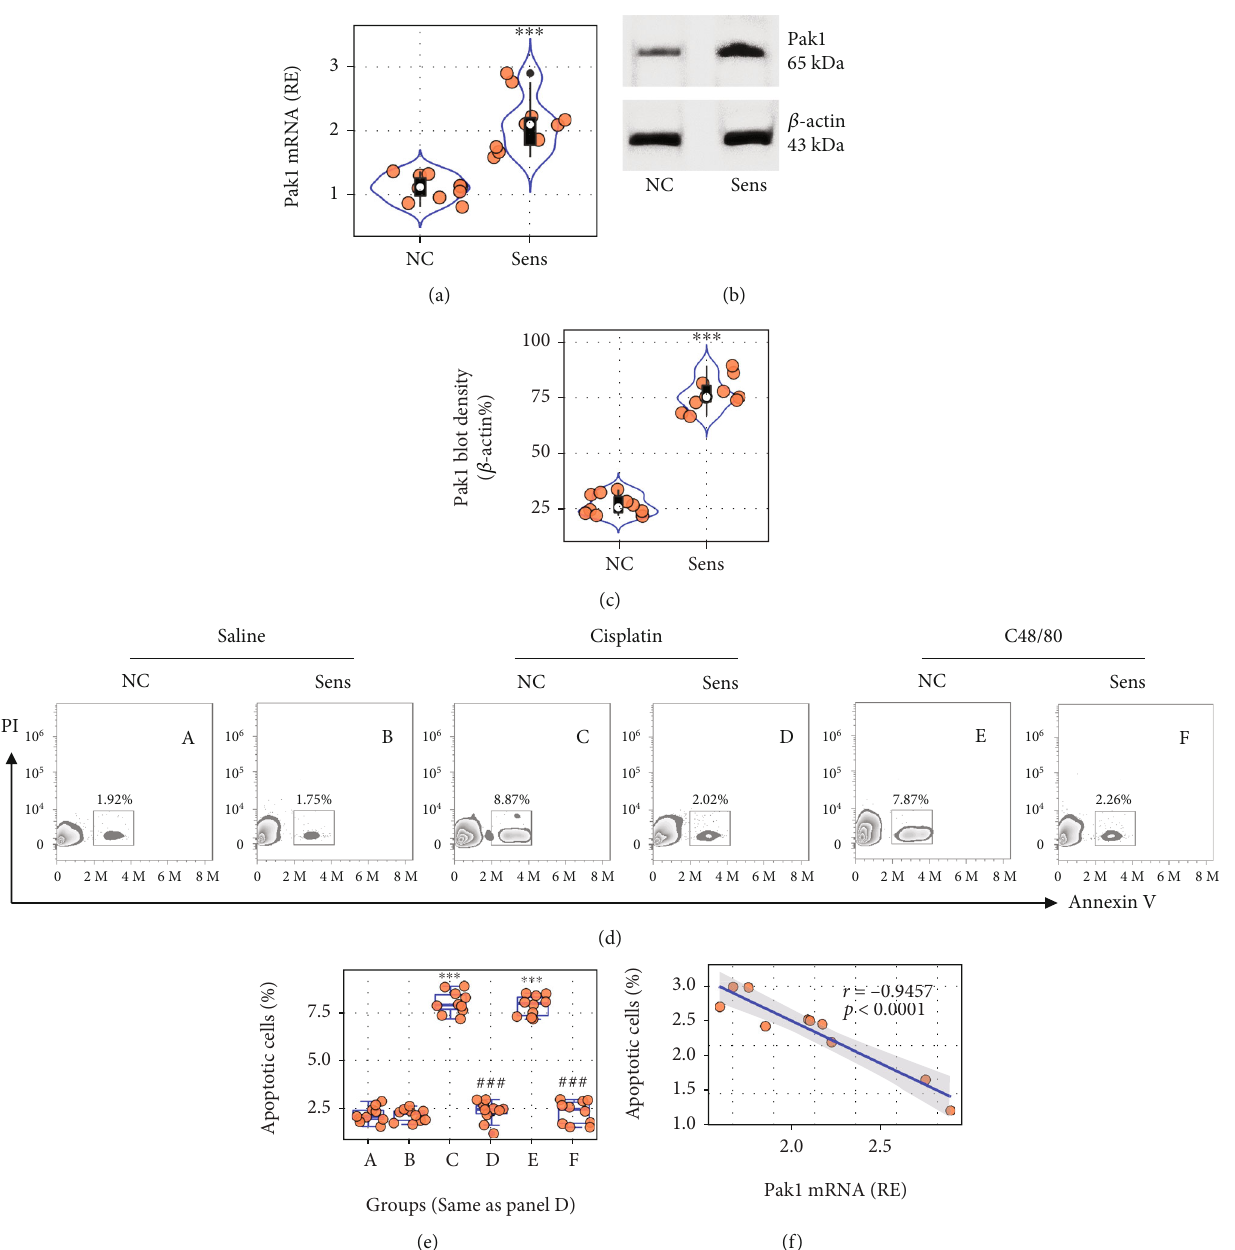
Figure 2: Assessment of the role of sensitization in Pak1 expression and apoptosis development in mast cells. (a, b) BMMCs were sensitized (Sens, in short) by exposing to OVA-speci fi c IgE in the culture overnight. Violin plots show Pak1 mRNA levels, and immunoblots show Pak1 protein levels in BMMCs. (c) Integrated density of Pak1 blot density. (d, e) Sensitized BMMCs were stimulated with cisplatin (20 μ M) or C48/80 (0.1 mg/ml) in the culture overnight. Gated FCM plots show apoptotic BMMC cells. Boxplots show apoptotic BMMC frequency. (f) A negative correlation between Pak1 mRNA levels in sensitized BMMCs and the cisplatin-induced apoptotic BMMC frequency. Each bubble in the violin plots and boxplots presents data obtained from one experiment. ∗∗∗ p < 0 : 001 (ANOVA+Dunnett ’ s test), compared with the NC (naïve control) group. NC: Naïve control